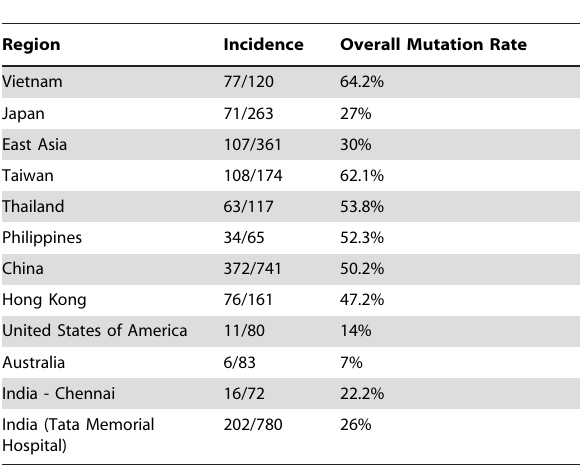
Table 1. Molecular Epidemiological status of EGFR mutation (adapted